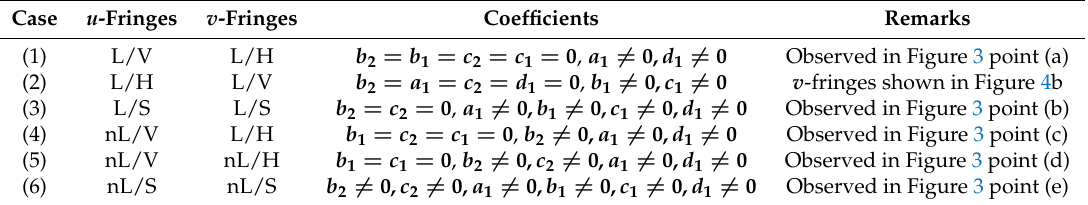
Table 1. u - and v -fringe shapes and corresponding coefficients of polynomial expressions.